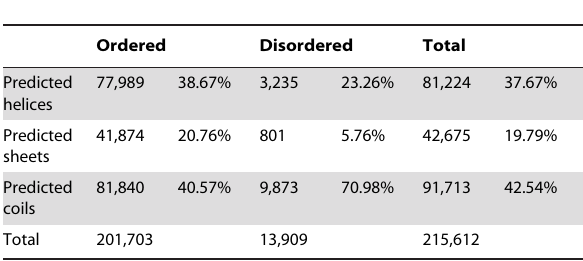
Table 4. Distribution of predicted secondary